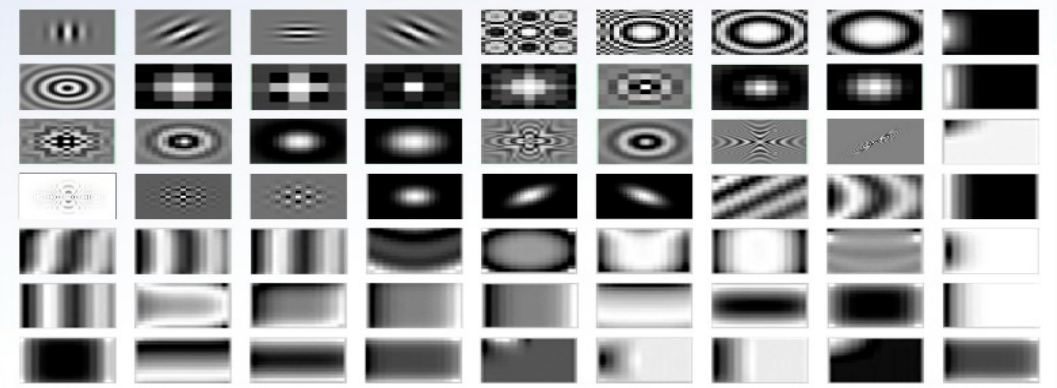
Figure 3. Convolution kernel of two dimensional Gabor filters with various shapes.